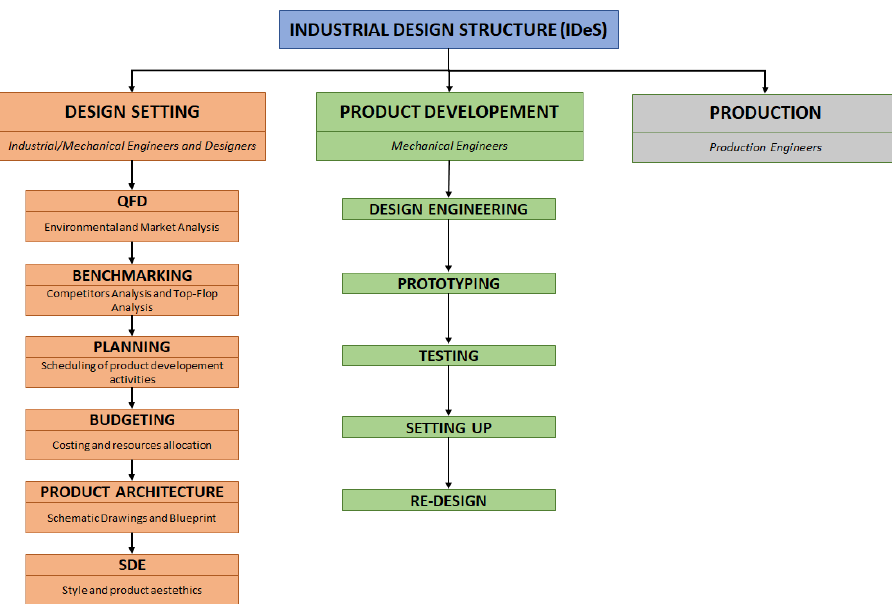
Figure 1. Logical diagram of the IDeS methodology’s various subphases, from market analysis to final product prototyping.